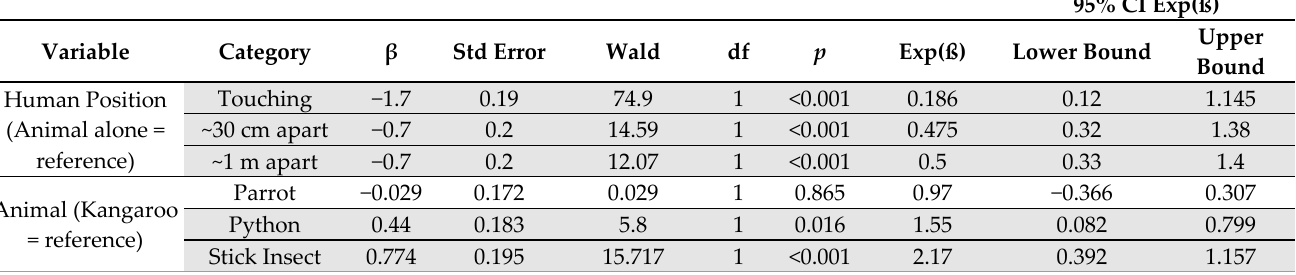
Table 3. Test statistics and effect sizes for variables in the final model to assess respondents’ agreement with the statement “the featured animal is displaying a natural behaviour”. Parameter estimate ( β ), standard error (SE), Wald statistics (Wald), degrees of freedom (df), level of significance ( p ), cumulative odds ratio (Exp ( β )), and 95% confidence interval of the cumulative odds ratio (95% CI Exp ( β )) for variables in the model. The answer options disagree, slightly disagree, neither agree nor disagree, slightly agree, and agree were coded as 1, 2, 3, 4, 5.